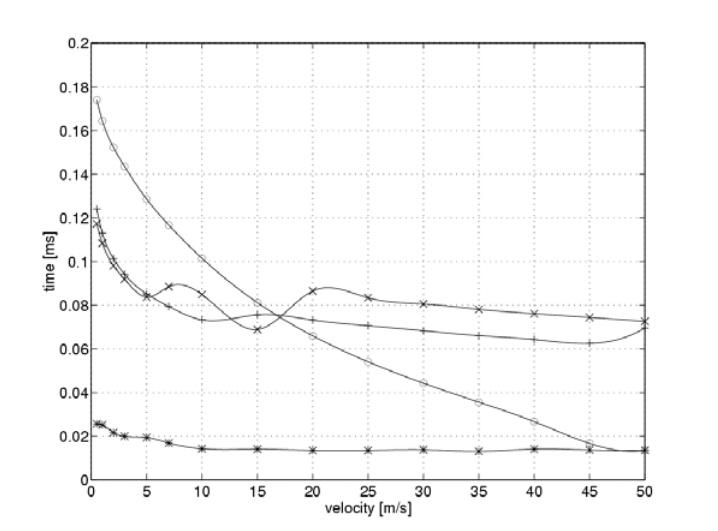
Figure 4. Reaching steady state after switching over to a higher heating level ("*" - optimal, "o" - minimum, "+" – intermediate, "x" – maximum gain